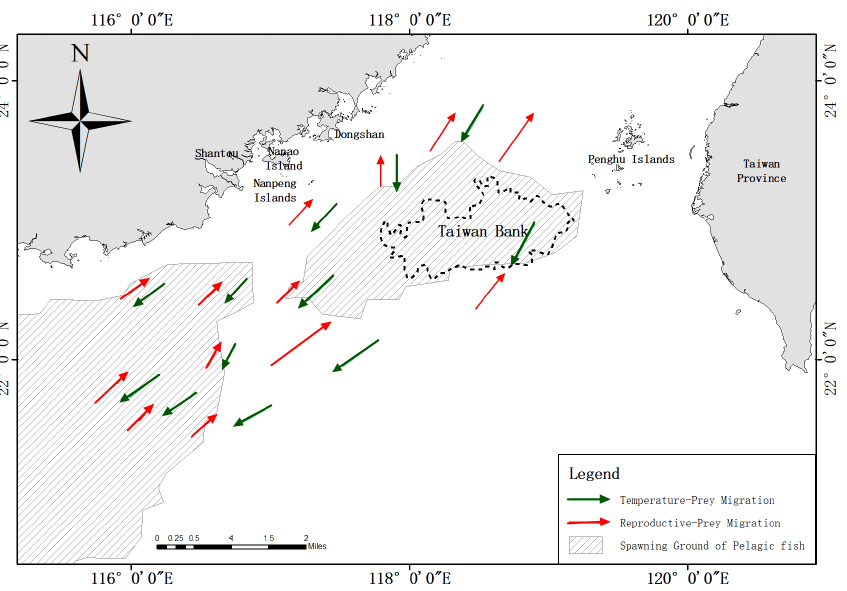
Figure 8. Distribution of spawning grounds and migration routes of pelagic fish in Shantou–Taiwan shoal fishing ground [92,93]. Forward slash area represents spawning grounds of the Pelagic Fish. Red arrow lines and green arrow lines respectively represent reproductive-prey migration and temperature-prey migration of Loligo formosana. The pelagic fishes usually overwinter and reproduce in deeper sea areas in winter. In spring and summer, they migrate from south to north or northeast, and in late autumn they migrate from north to south due to decreasing temperature [86,94,95].